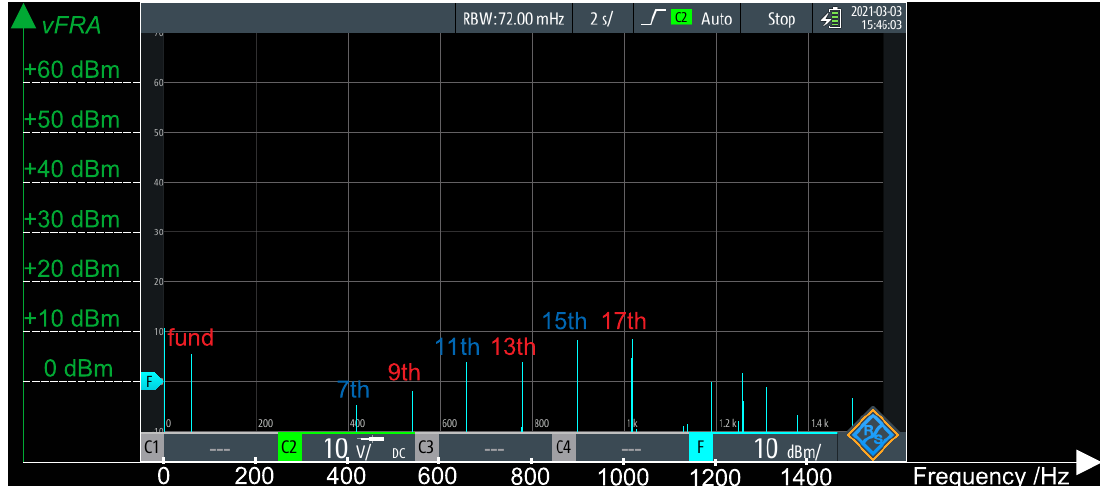
Figure 14. FFT of residue voltage v FRA